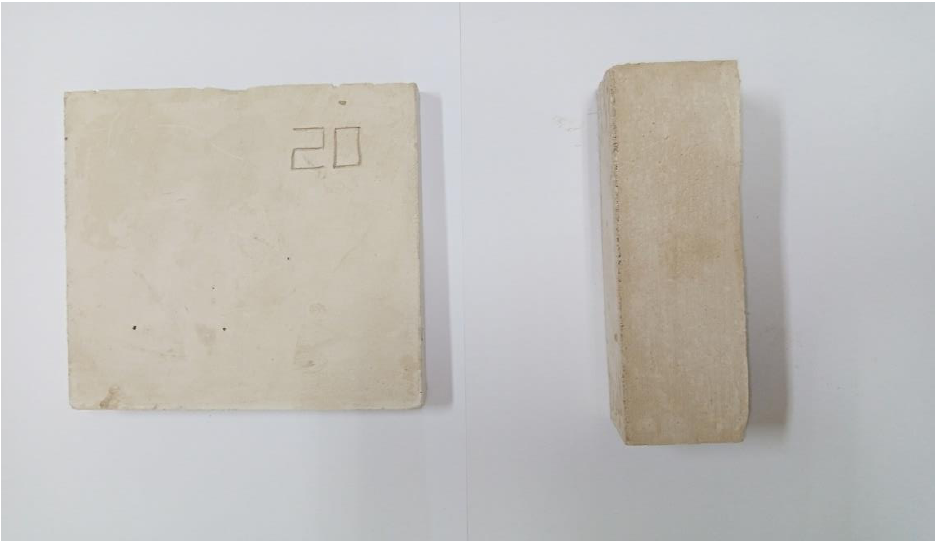
Figure 1. Geometric forms of the PGM 1/1 and PGM 1/2 samples.